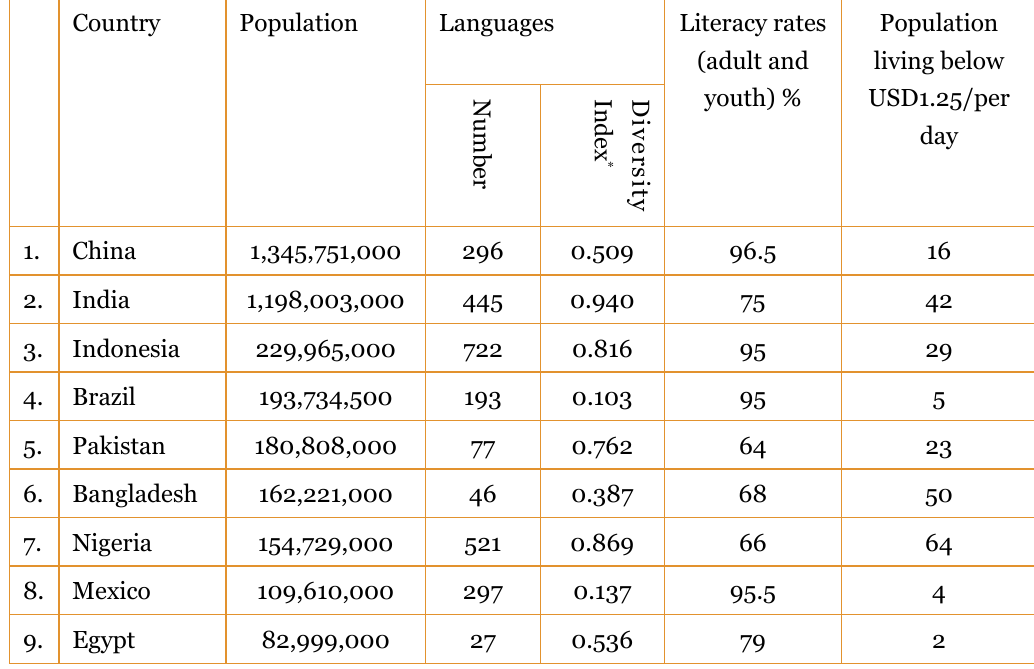
E-9 Countries’ Statistics Country Population Languages Literacy rates